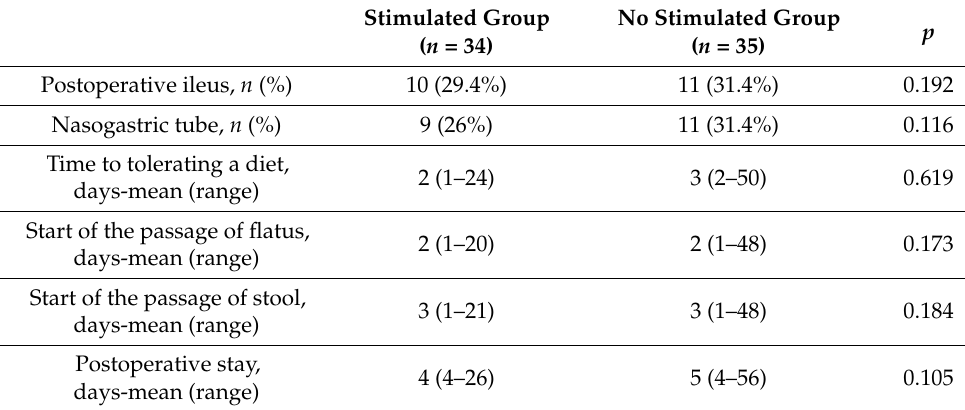
Table 2. Postoperative results.